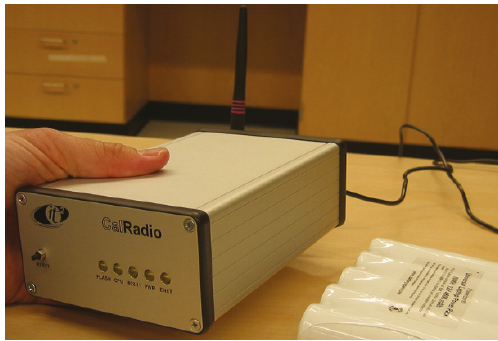
Figure 5: CalRadio external case and battery.